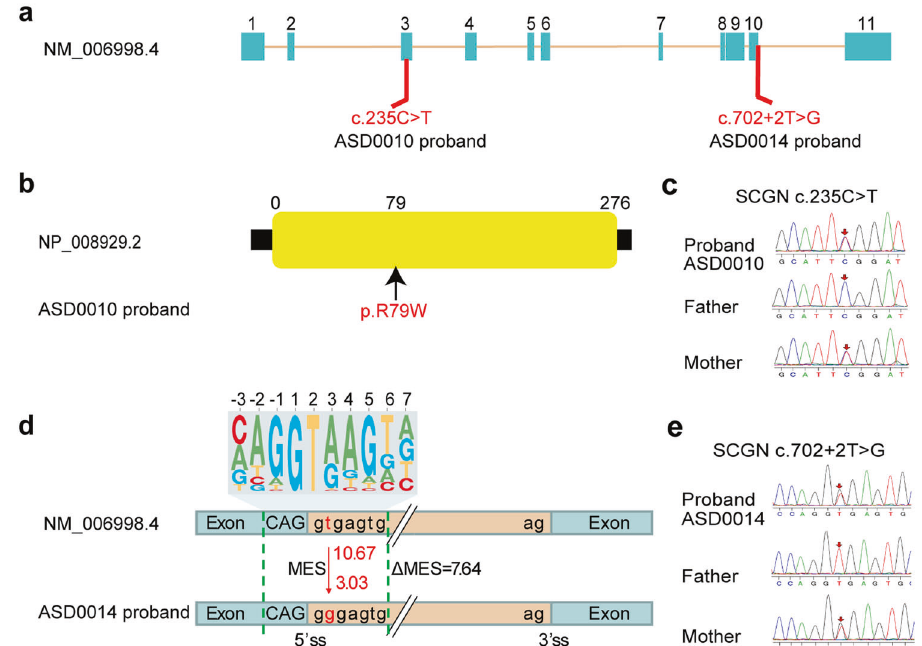
Fig. 1 Mutations in SCGN are linked to ASD. a Schematic diagram of mutation sites in two ASD probands. b ASD0010 carries one heterozygous, missense mutation (R79W) in the SCGN gene. c Sanger sequencing traces of unaffected parents and affected ASD0010 proband. d ASD0014 carries a heterozygous mutation in SCGN immediately after exon 10, which likely affect gene splicing. 10.67 and 3.03 are predicted 5 ’ splice site score for WT and the mutation. The top panel is the 5 ’ splicing site motif. MES Maximum Entropy Score. e Sanger sequencing traces of unaffected parents and affected ASD0014